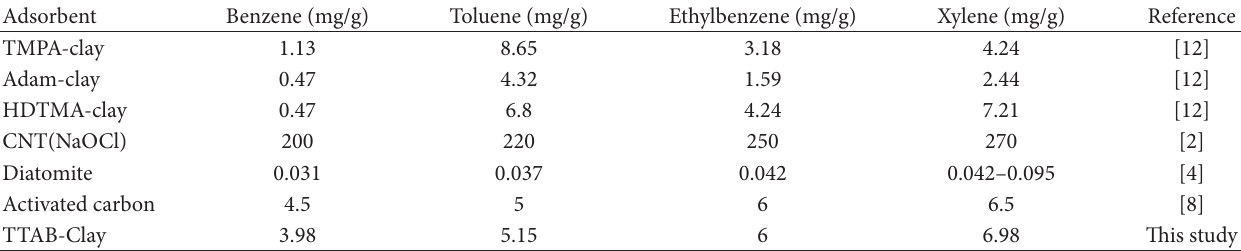
T 2: Removal of BTEX from aqueous solutions by various adsorbents.